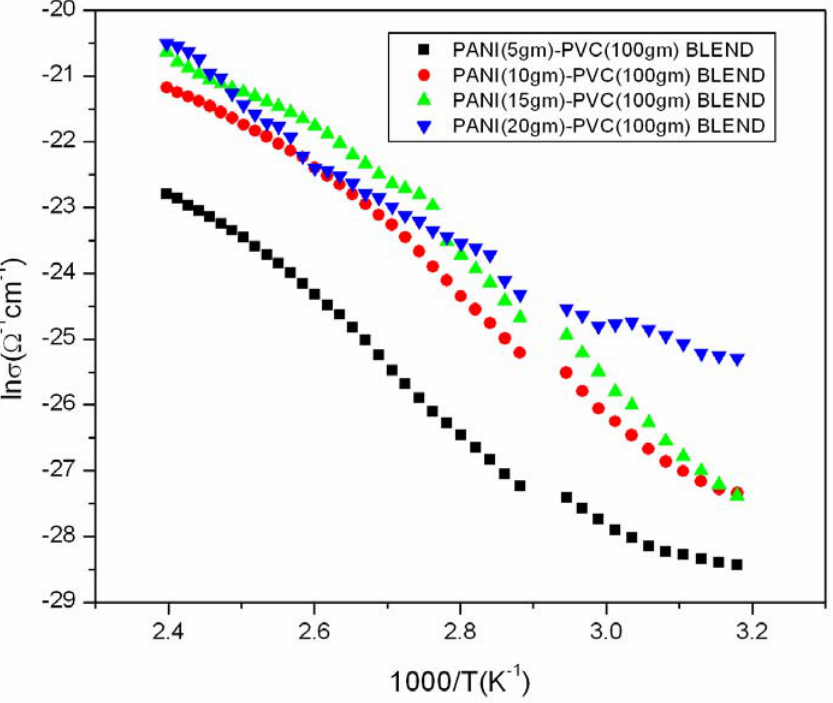
Fig. 7 Variation of dc conductivity with 1000/T for PANI doped with 25 % sulfamic acid in PANI-PVC